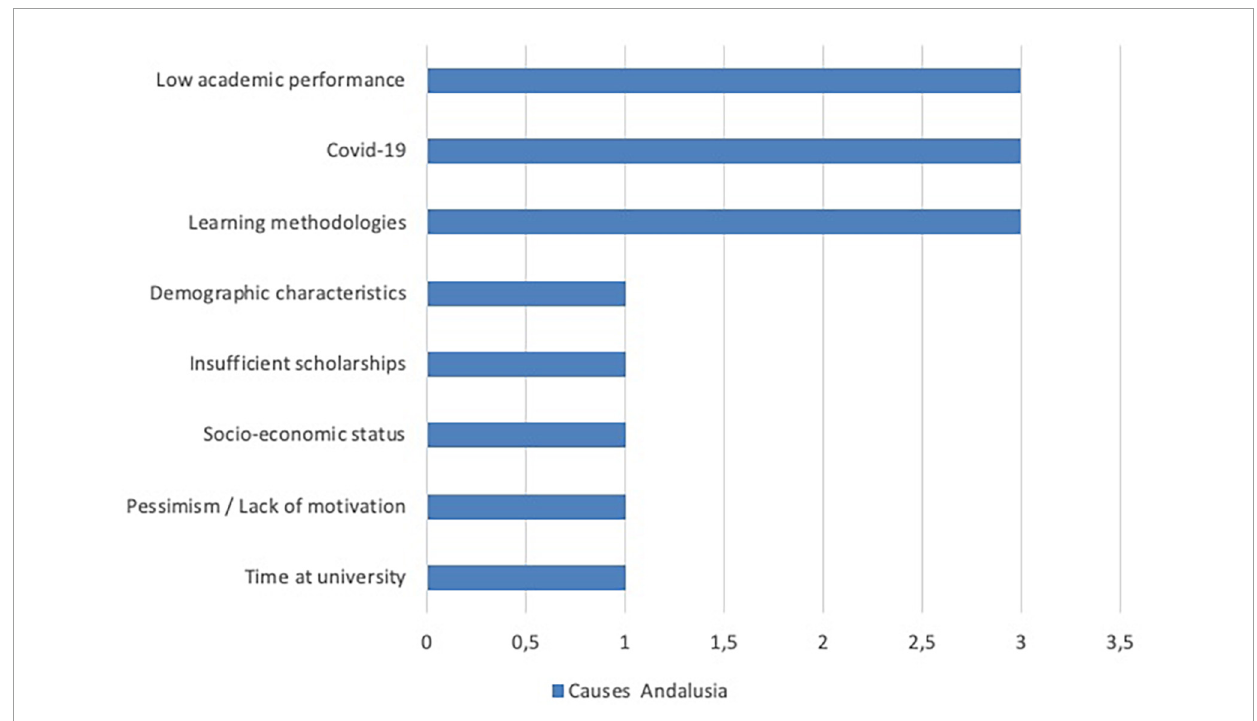
FIGURE4 Causes of academic dropout in Andalusia. Source: Own elaboration.